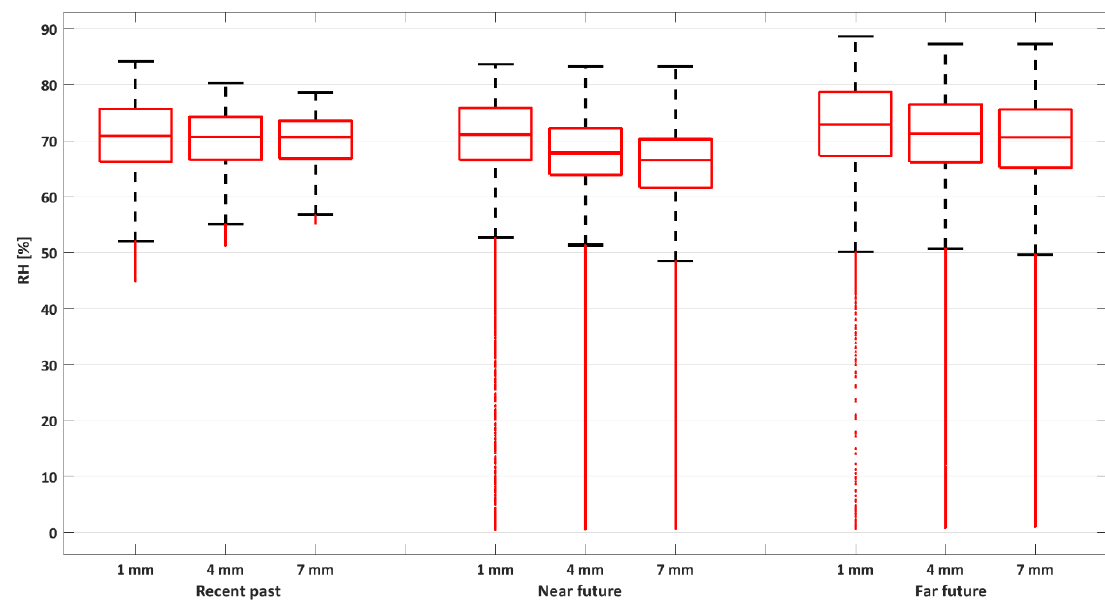
Figure 6. RH distribution in wood at different depths, using the WUFI ® Pro method using the indoor data from Roggersdorf church for three 30-year time periods: recent past (1960–1990), near future